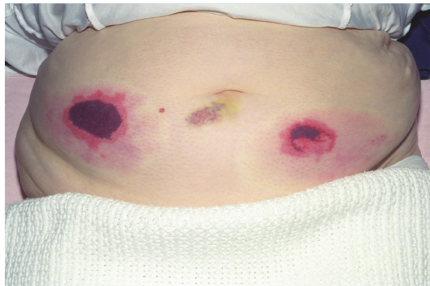
Figure 1: Skin necrosis on anterior abdominal wall after treatment with